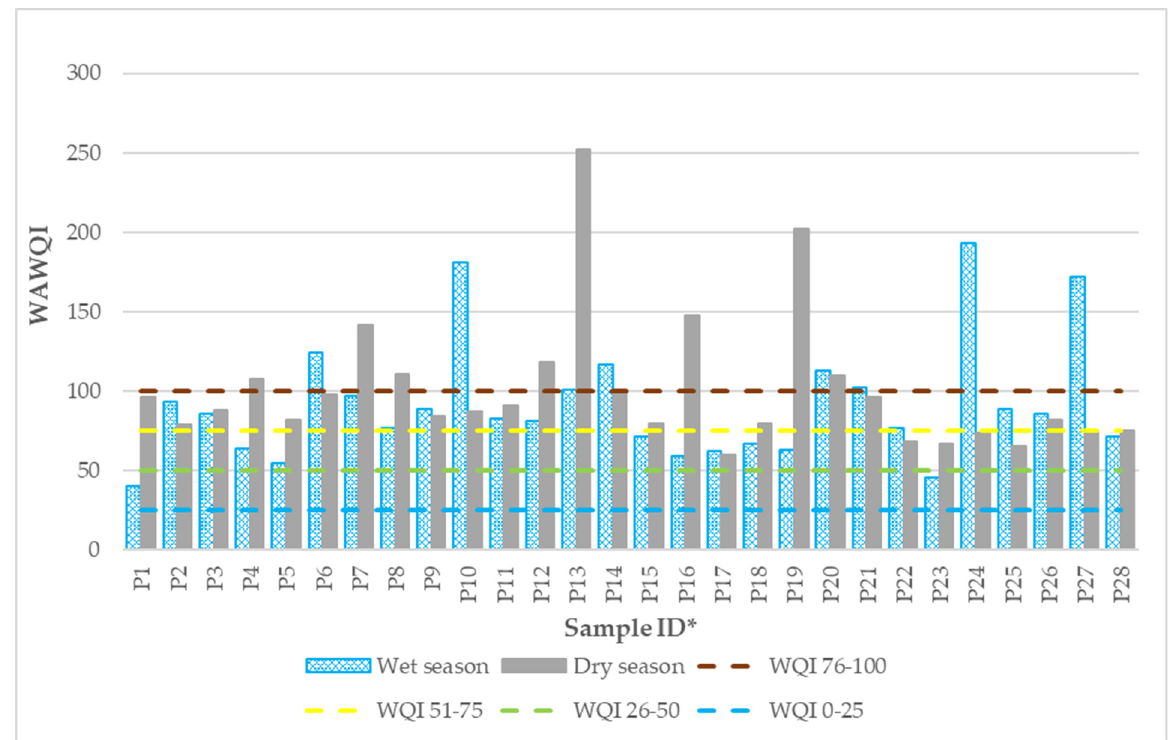
Figure 11. WAWQI at MPMF by season in 2018. * Sample ID is mentioned in Table 2 with specific location